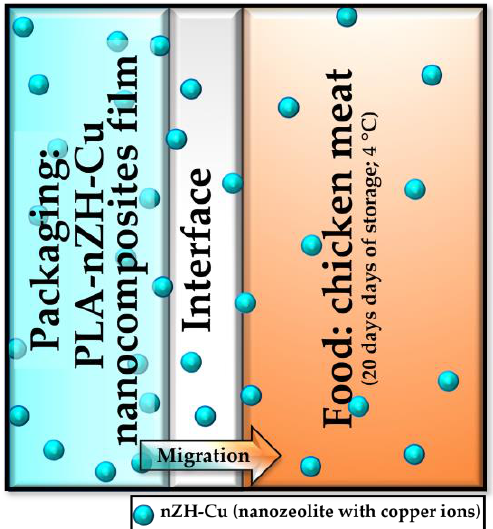
Figure 6. Scheme of the migration process, when the PLA-nZH-Cu nanocomposite film was in contact with the chicken meat. Adapted from Barros-Velázquez (2016) [1].